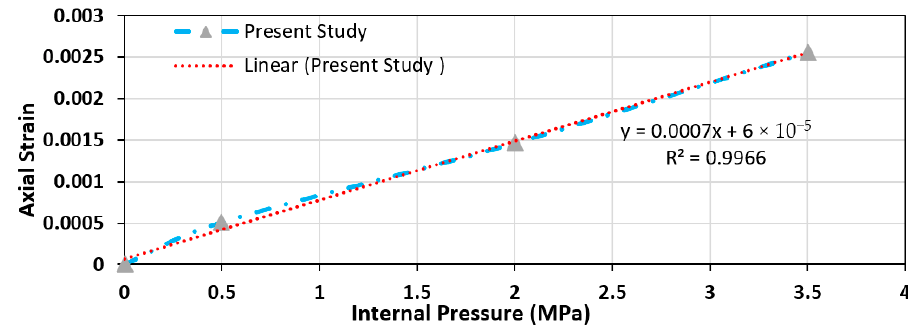
Figure 10. Validation plot for axial strains against internal pressure.